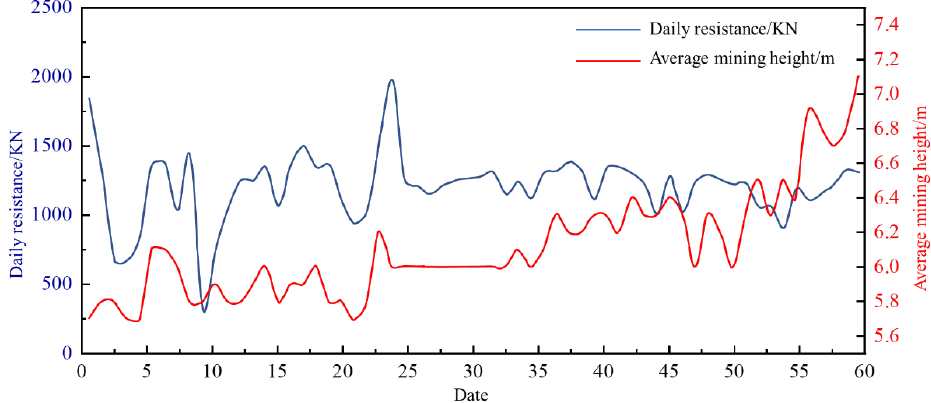
Figure 12. Relationship between mining height and support working